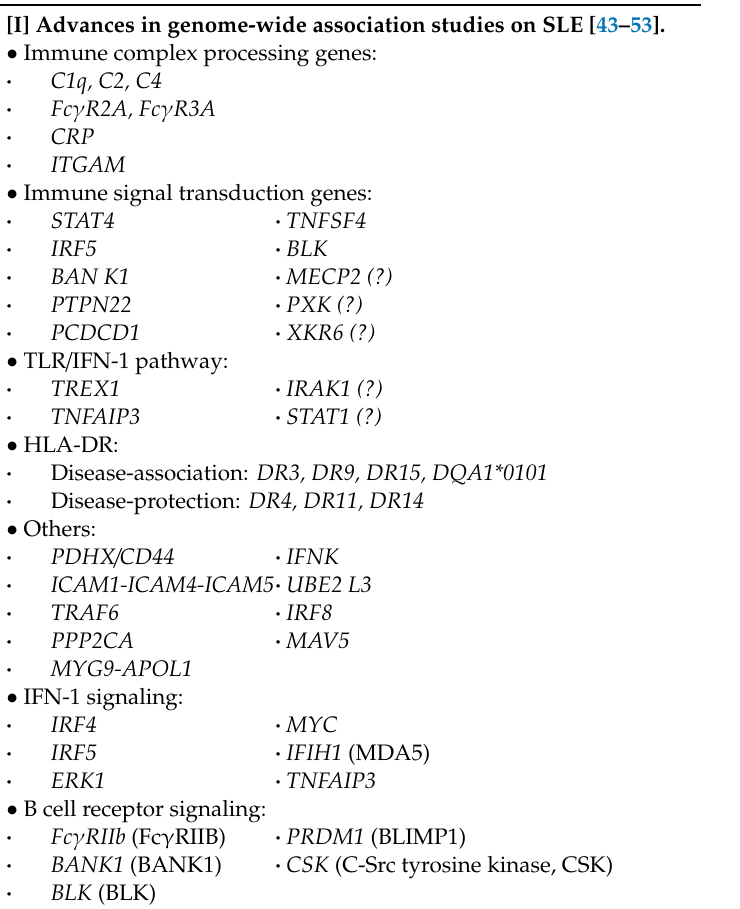
Table2. Geneticlociassociatedwithlupuspathogenesisdemonstratedinthebigdatafromgenome-wide association